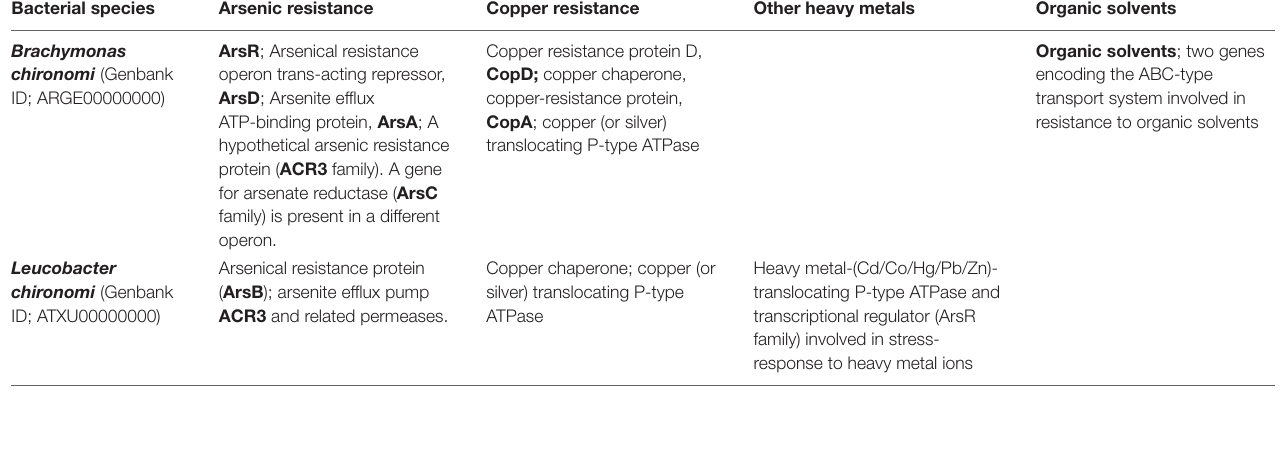
TABLE 2 | A list of genes encoding enzymes with predicted resistance to toxic substances (data from Laviad et al., 2015a,b). Bacterial species Arsenic resistance